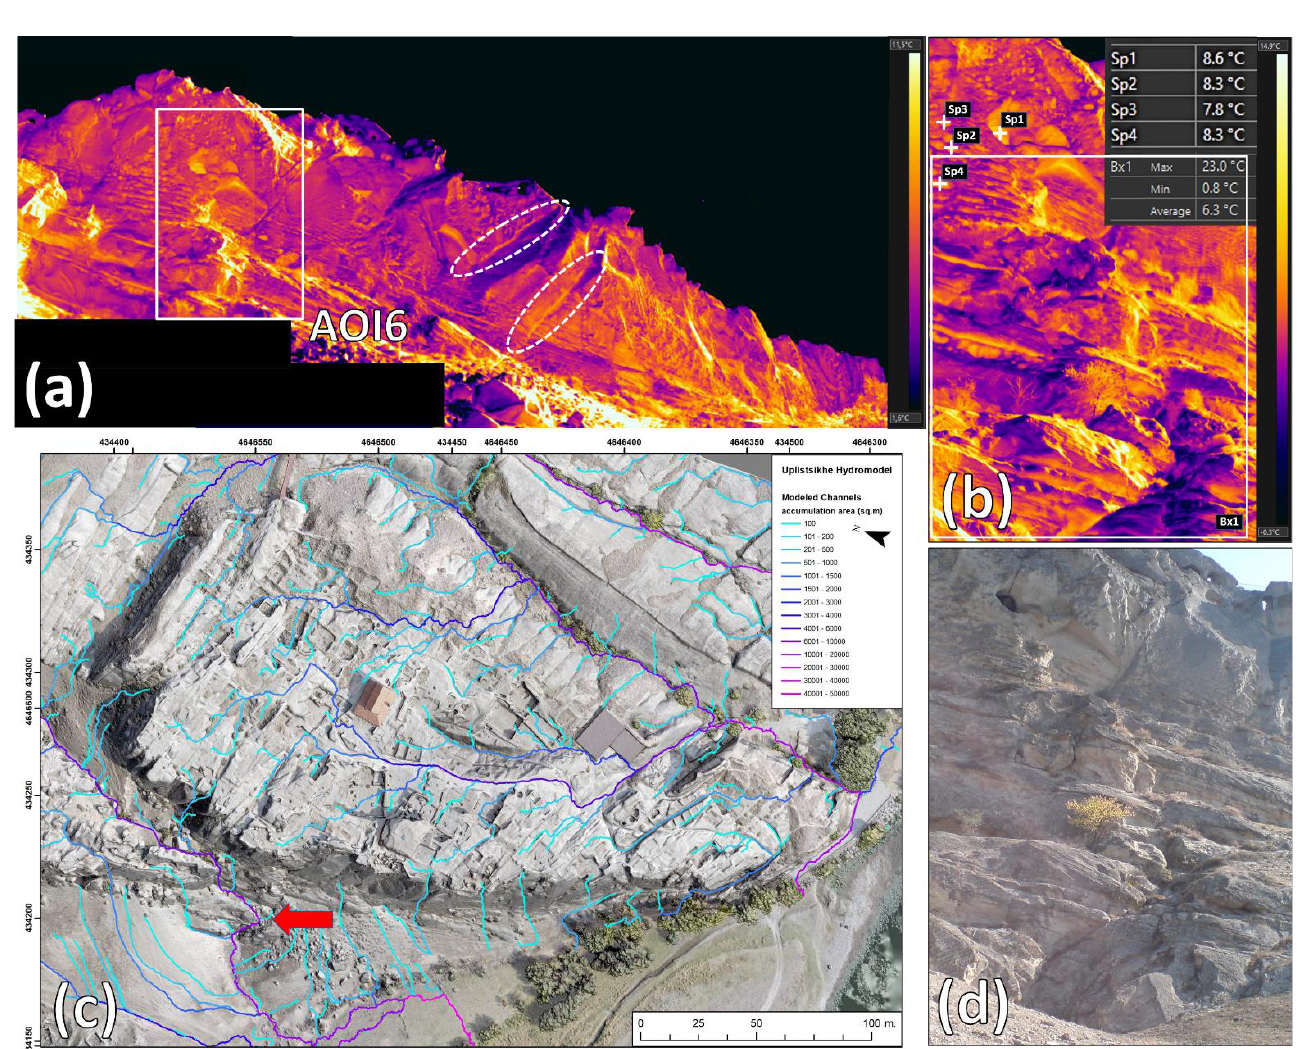
Figure 16. Outcomes of the IRT surveys: mosaicked thermograms (2800 × 850 pixel) ( a ) showing open fractures along J4 (white dashed ovals) and AOI 6 highlighted in b, d; detail of the cold thermal anomaly ( b ) with spots showing the warm thermal anomalies where the corrasion cavities develop (Bx = box plot showing min., max., avg. temperature); modelled ephemeral drainage network of the site ( c ) (red arrow highlights the ephemeral stream developing the cold thermal anomaly in b ); correspondent optical image of b ( d ).